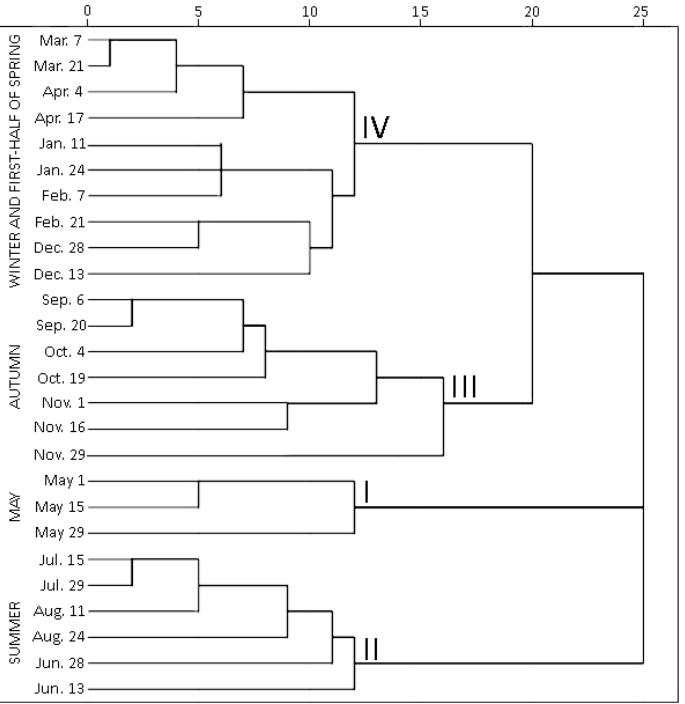
Figure 3. Dendrogram estimating contents of phenolic and triterpenic compounds in lingonberry leaves based on their collection date.